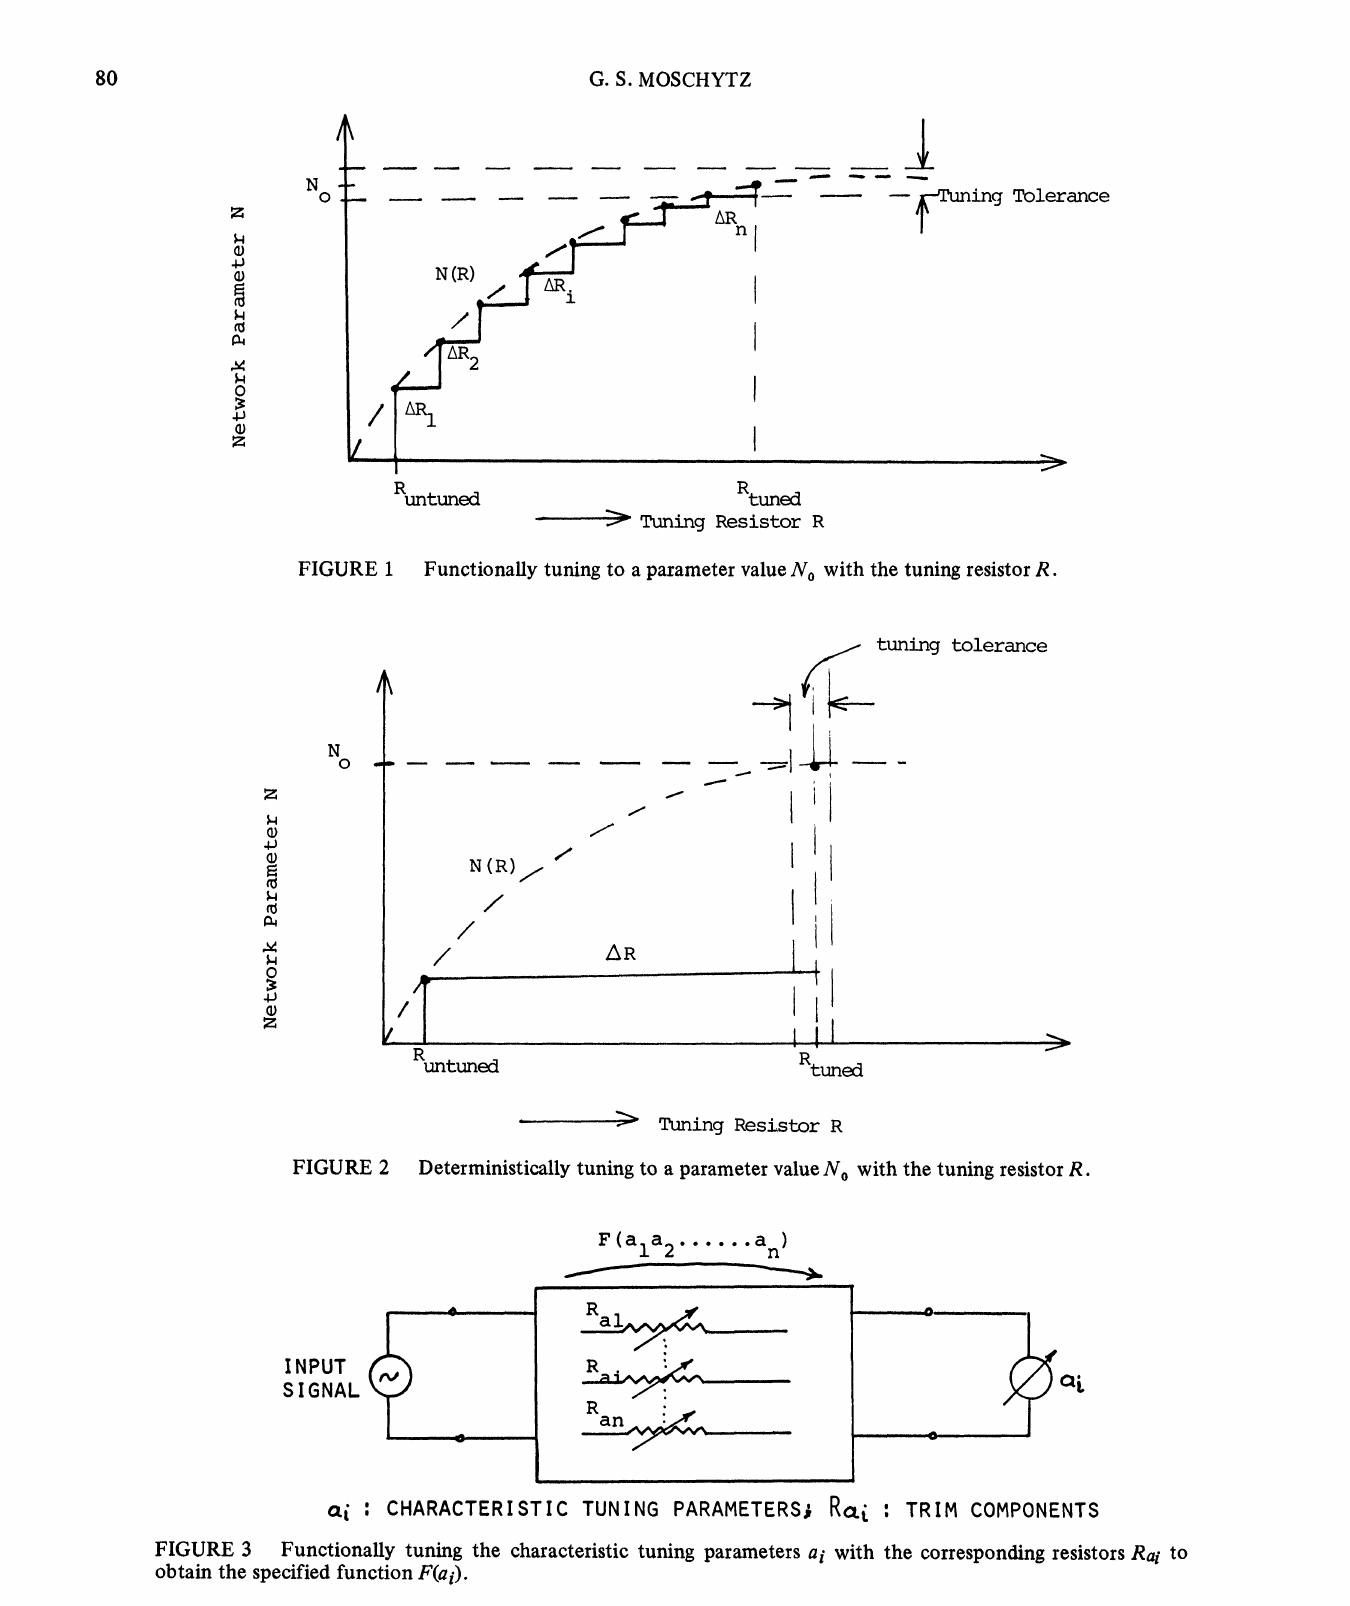
O-i CHARACTERISTIC TUNING PARAMETERS; Functionally tuning the characteristic tuning parameters a with the corresponng resistors Rai to obtain the specified function